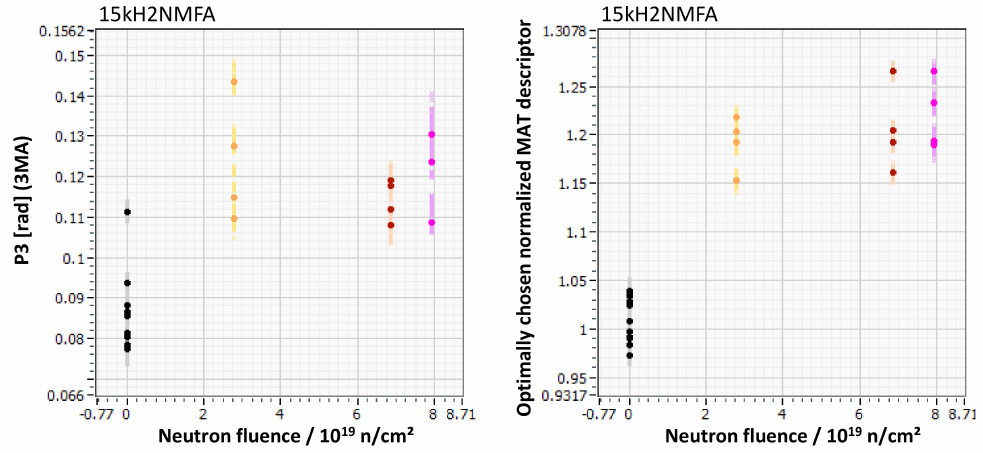
Figure 12. Dependency of the amplitude of third harmonics P3 ( left ) and of the MAT descriptor ( right ) on the fluence level for eastern RPV material 15Kh2NMFA.